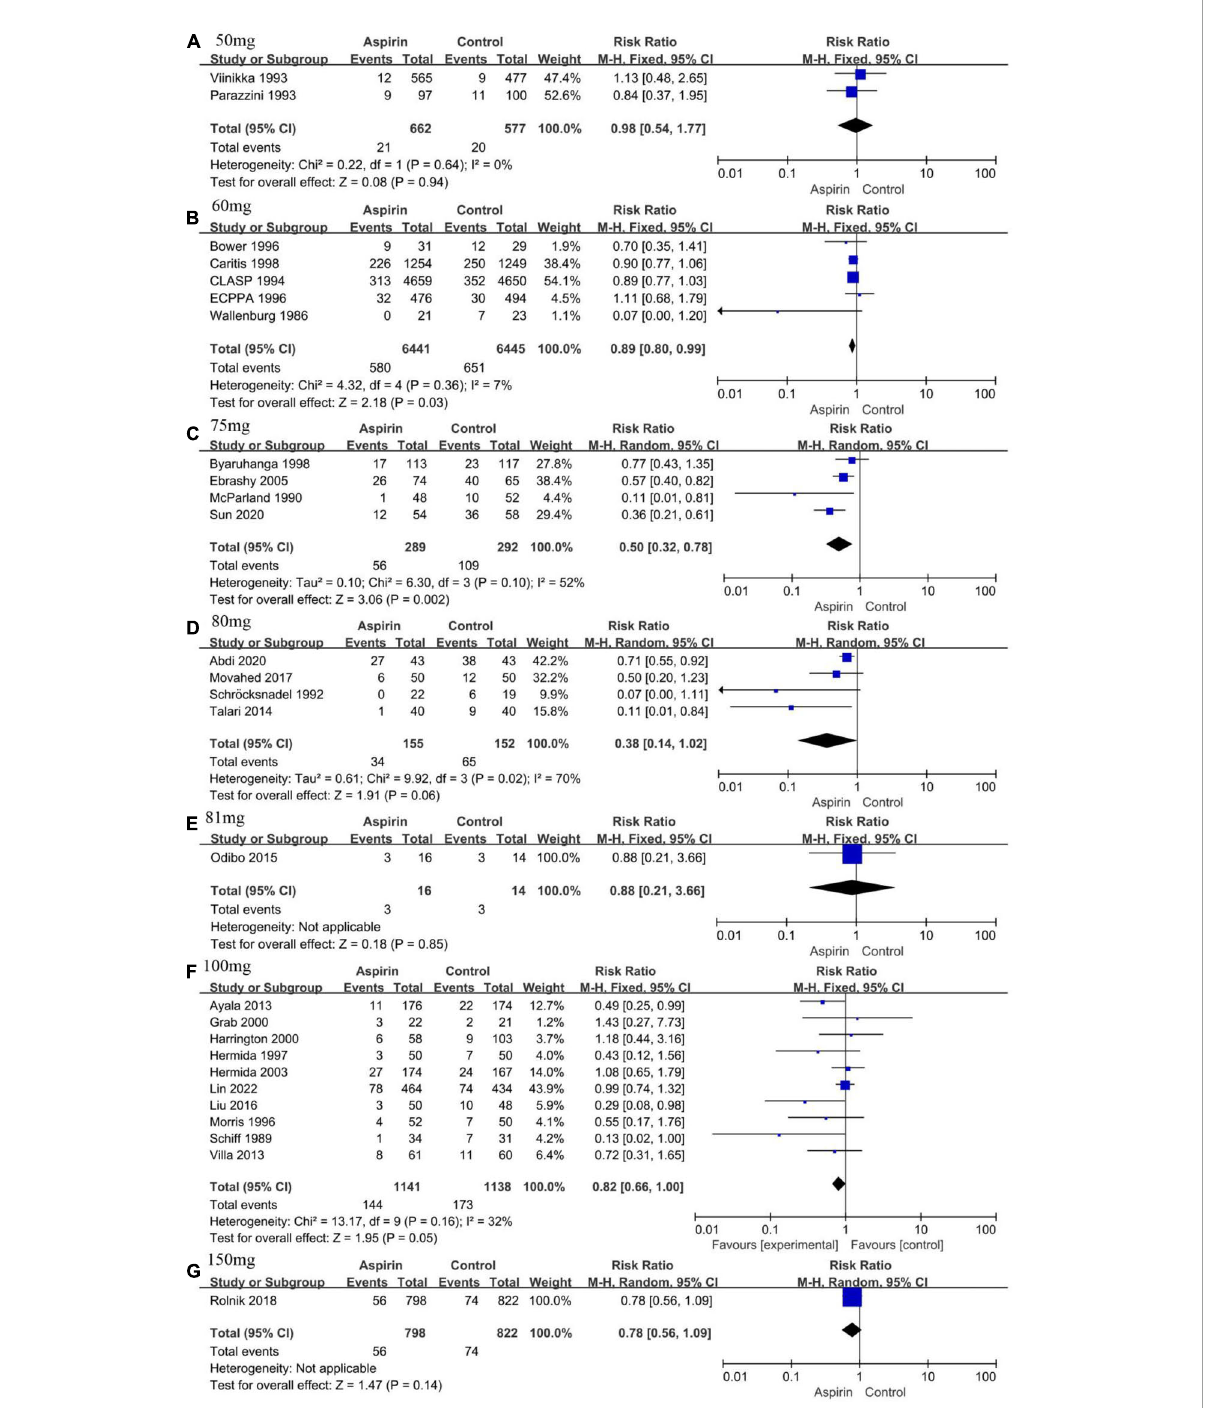
FIGURE5 Forest plot showing subgroup analysis according to aspirin dose. (A) 50 mg/day. (B) 60 mg/day. (C) 75 mg/day. (D) 80 mg/day. (E) 81 mg/day. (F) 100 mg/day. (G) 150 mg/day.